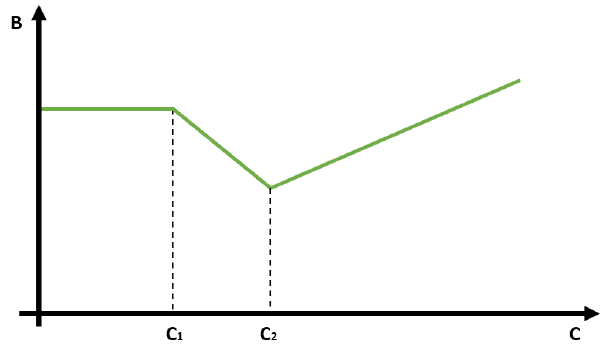
Figure 1. Schematic representation of the organic carbon flux B evolution with carbon content